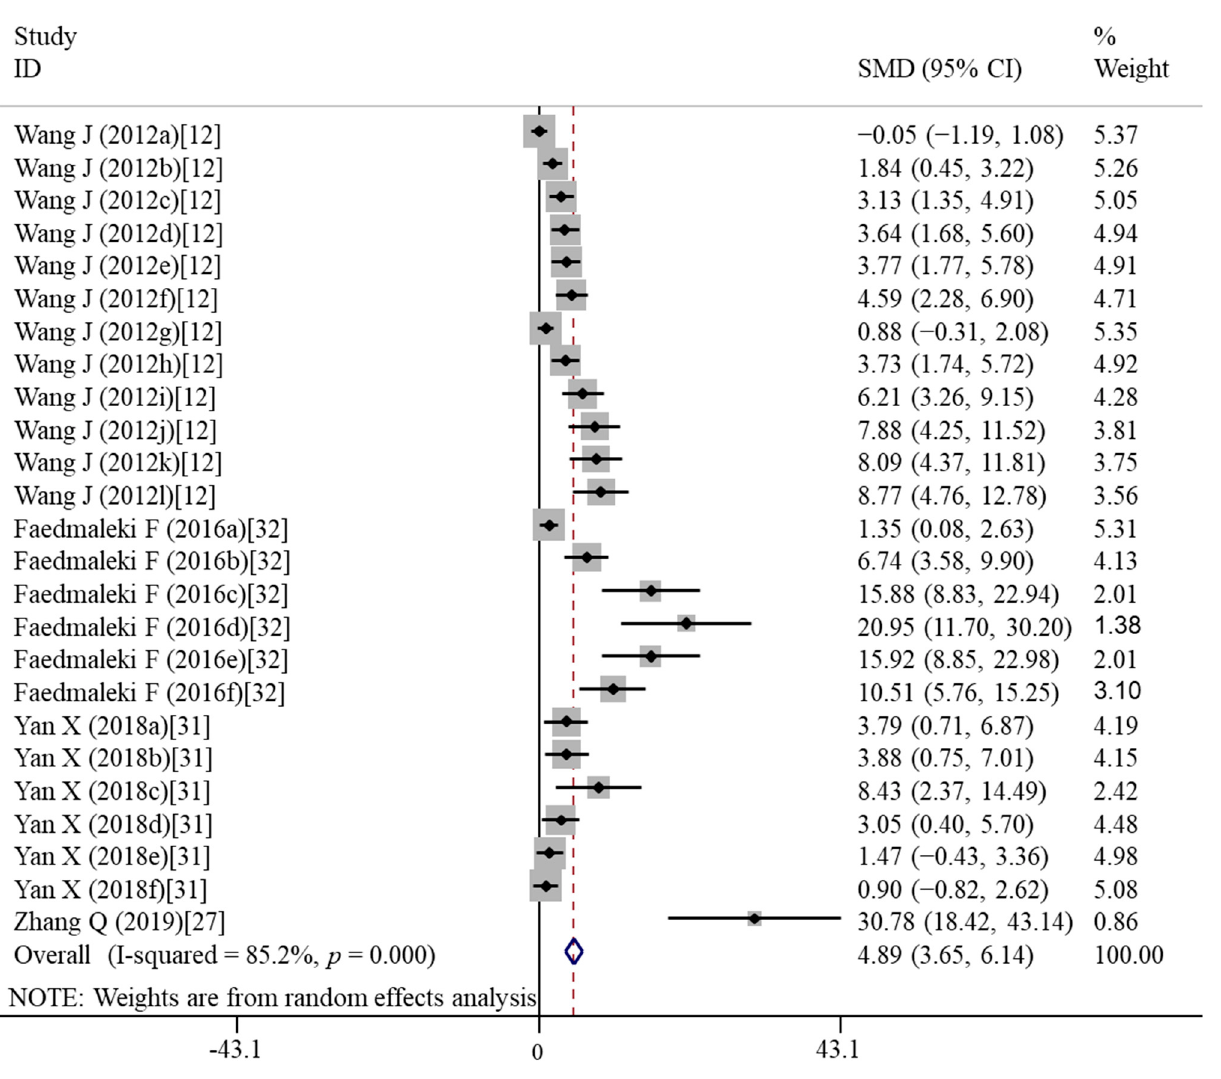
Figure 2. Forest plots showing the protective effects of vitamin E on the cell viability compared with the nanomaterial exposure group. a, b, c, d, e, f of the study of Wang et al. represent treatment with 10, 50, 200, 500, 1000, 2000 µ M of vitamin E for 24 h; g, h, I, j, k, l of the study of Wang et al. represent treatment with 10, 50, 200, 500, 1000, 2000 μ M of vitamin E for 48 h. a, b, c, d, e, f of the study of Faedmaleki et al. represent treatment with 50, 250, 500, 1000, 2500, 5000 μ M of vitamin E for 24 h. a, b, c, d, e, f of the study of Yan et al. represent treatment with 2, 5,10, 25, 50, 100 μ M of vitamin E for 24 h. SMD, standardized mean difference; CI, confidence interval. [12,27,31,32]